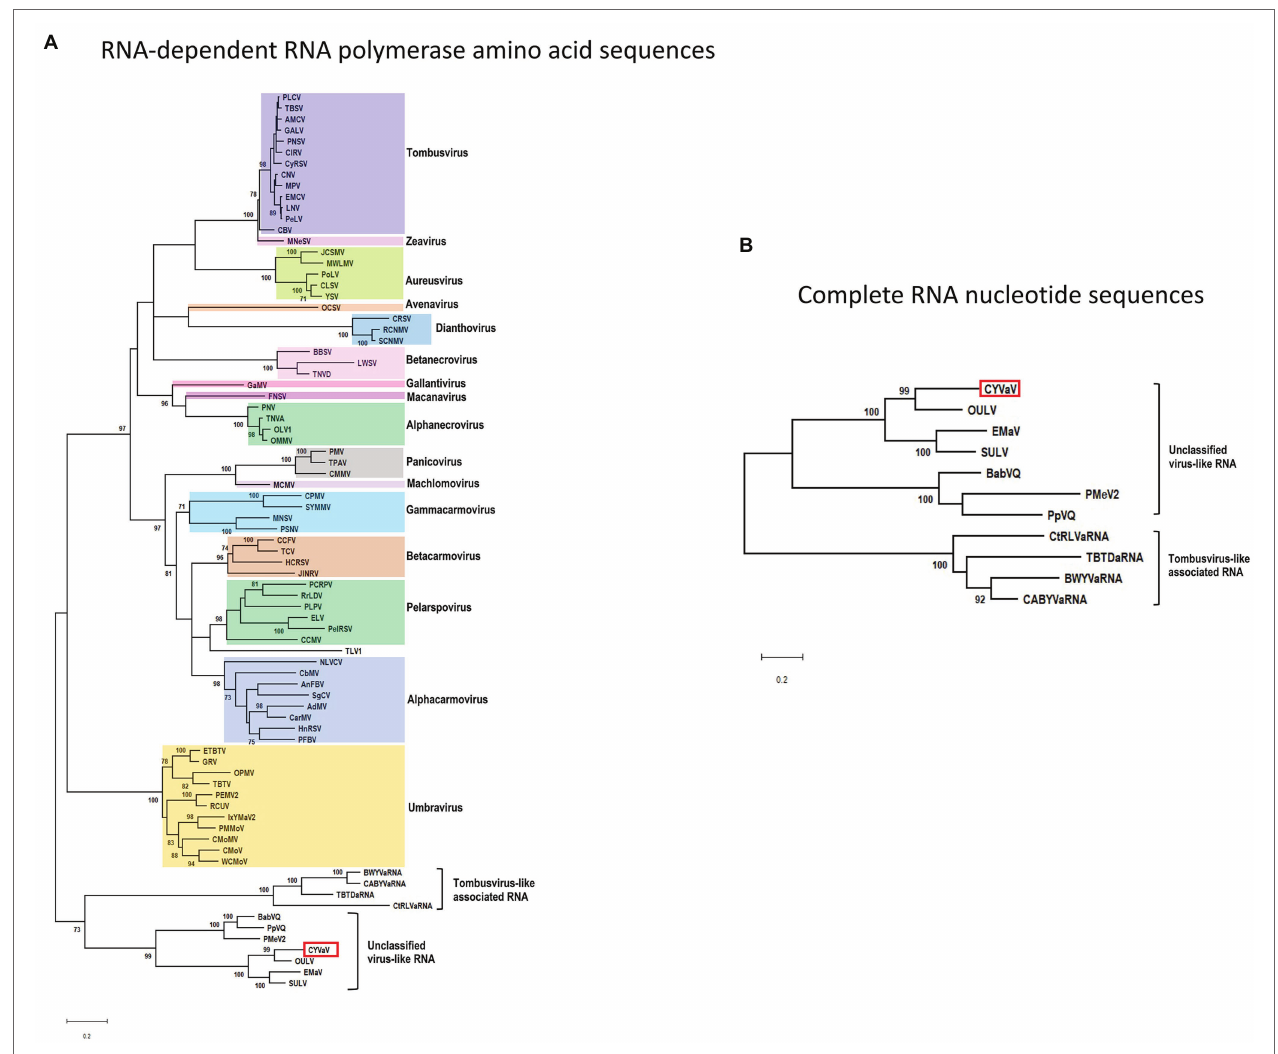
FIGURE 6 | Phylogenetic relationships of CYVaV and members of the family Tombusviridae . Maximum likelihood phylogenetic trees of the conserved RdRp amino acid sequences (A) and complete RNA nucleotide sequences (B) were constructed using MEGA X program (Kumar et al., 2018). Branch lengths represent genetic distances. The numbers on the branches indicate bootstrap percentage based on 1,000 replications. Major virus genera are highlighted in different colors. The full names of the viruses and accession numbers used in the phylogenetic analysis are listed in Supplementary Table 3